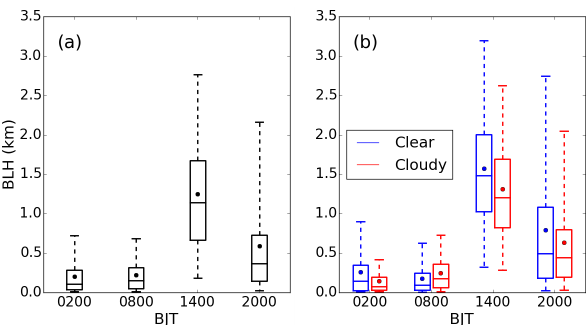
Figure 11. (a) Box-and-whisker plots showing the 5th, 25th, 50th, 75th and 95th percentile values of CMA-BLH at 02:00, 08:00, 14:00 and 20:00BJT in summer based on all the summertime soundings in China. (b) Box-and-whisker plots showing CMA- BLH in summer under clear (total cloud cover ≤ 20%, in blue) and cloudy (total cloud cover ≥ 80%, in red) conditions. Note that the rainy days are not considered in (b) .